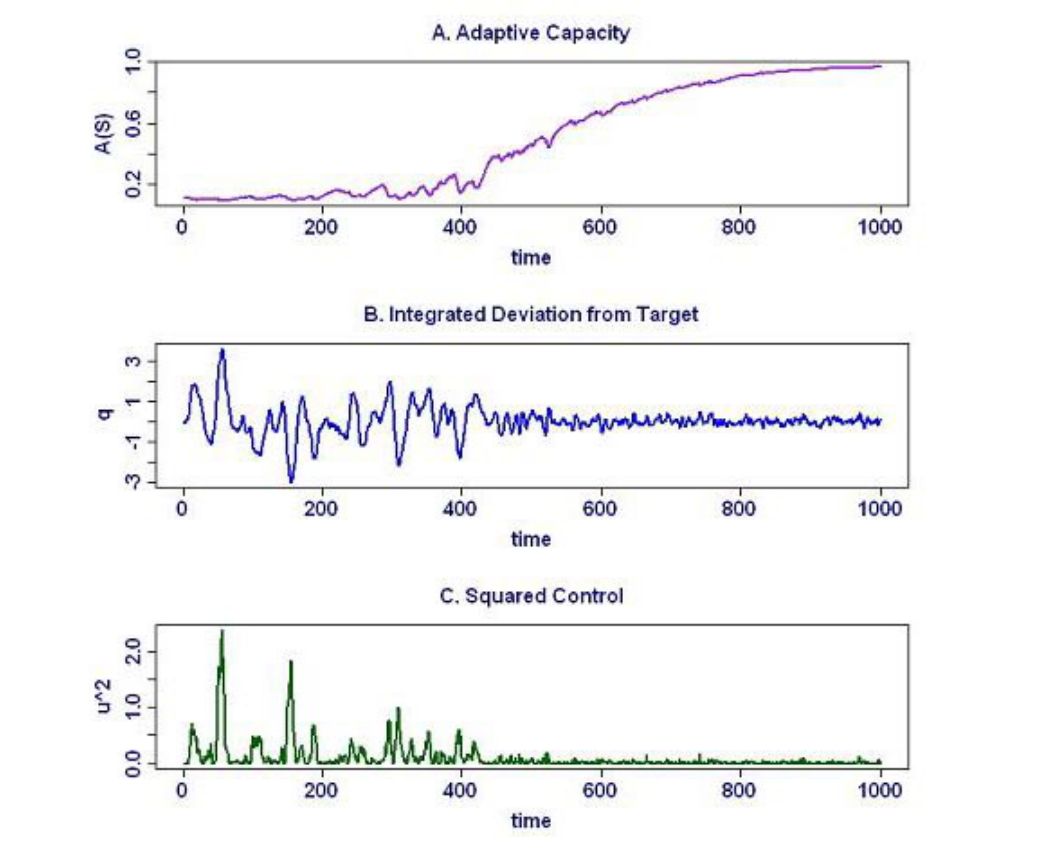
Fig. 4. Emerging from a rigidity trap: time series as S* is lowered gradually from 9 to 5 over 1000 time steps. (A) Adaptive capacity A(S[t]). (B) Integrated deviation from target, q[t]. (C) Squared control, u[t]